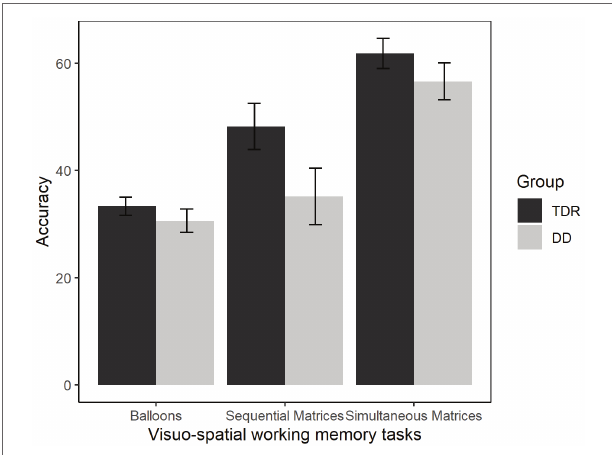
FIGURE 6 | Accuracy in VSWM tasks. Error bars represent standard errors. TDR, typically developing readers, DD, developmental